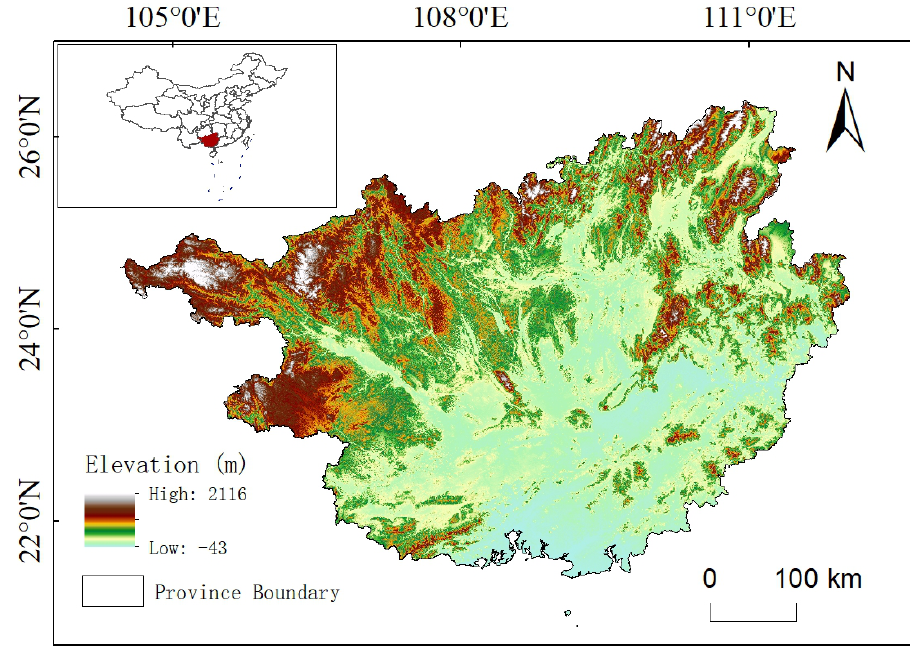
Figure 1. Geographical location and elevation map of Guangxi, China.